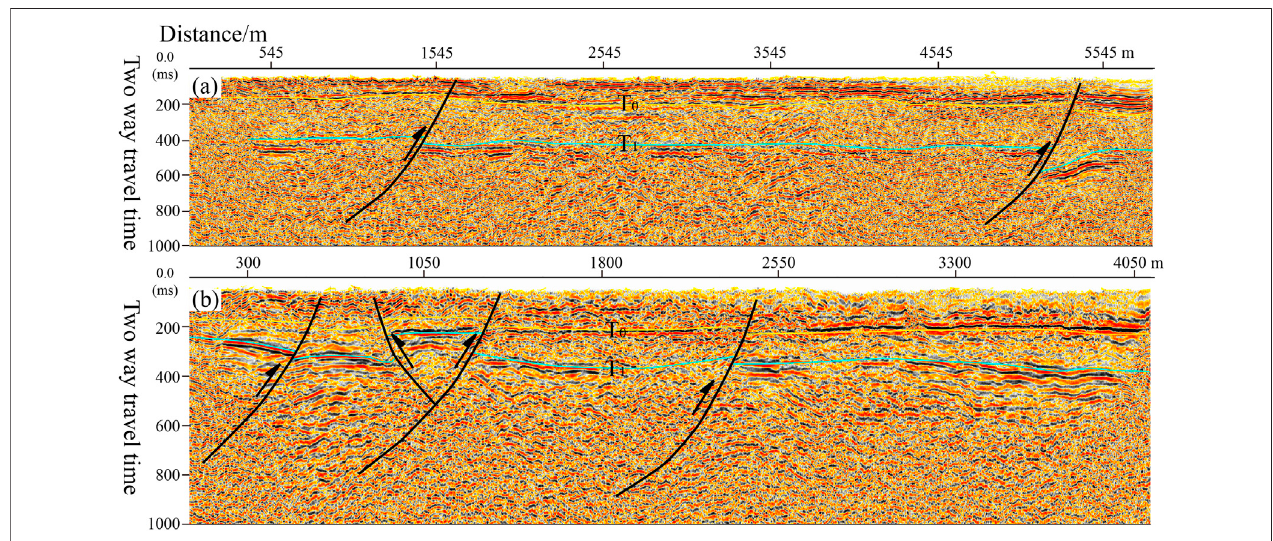
FIGURE 9 | (A) Seismic re fl ection pro fi les across SMQBF at Golmud river site is shown in Figure 2 (Pro fi le A-A ’ ). (B) Seismic re fl ection pro fi les across SMQBF at Hongliugou site is shown in Figure 2 (Pro fi le B-B ’ ). T 0 represents conjectural bottom of the quaternary strata. T 1 represents conjectural bottom of the Cenozoic strata.